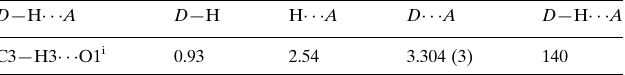
Hydrogen-bond geometry (A˚ , (cid:2)